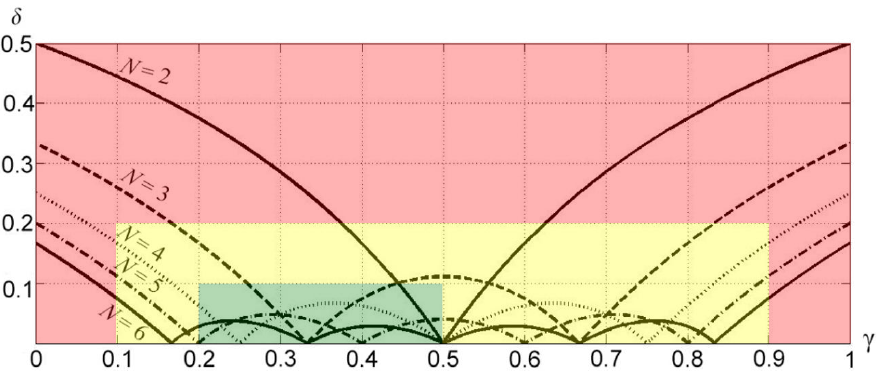
Figure 7. Error δ for input borderline current of N = 2–6 interleaved cells [34].